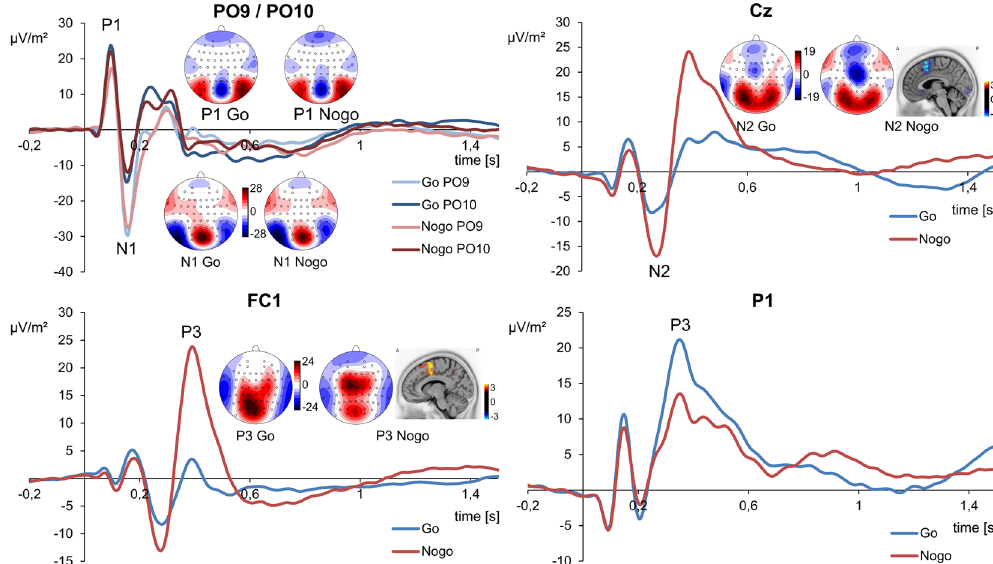
Figure 1. Event-related potential (ERP) components on Go and Nogo stimuli presentations. Plots are given for electrodes PO9/PO10 depicting P1 and N1 ERP, electrode Cz for N2, electrode FC1 for Nogo-P3 as well as electrode P1 for Go-P3. ERPs on Go stimuli are shown in blue, ERPs on Nogo stimuli are shown in red. The scalp topography plots reveal the distribution of voltages at the time point of the peak maximum of each ERP component. Time point zero denotes the time point of stimulus delivery. For N2 and P3 ERP, the results of sLORETA source estimation are